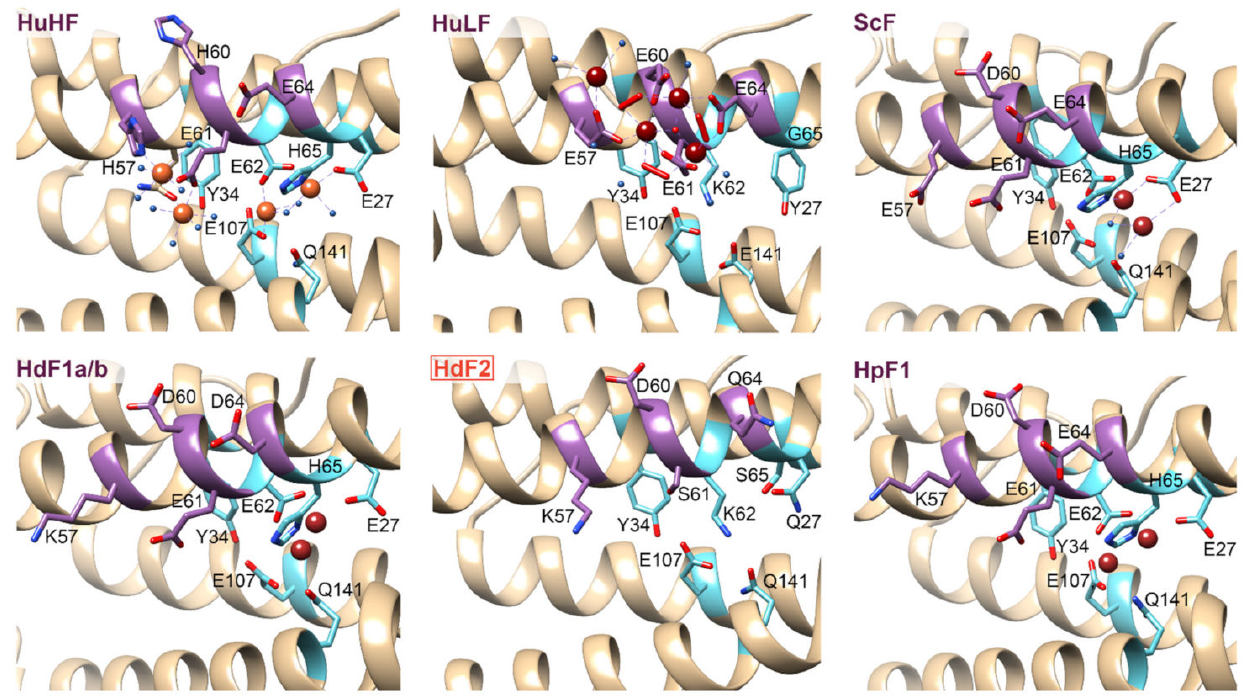
Figure 3. 3D structures of the regions corresponding to ferroxidase di-iron center (cyan) and nucleation site (purple) of H. sapiens ferritins HuHF and HuLF (PDB IDs: 4OYN, 5LG8), bivalve Sinonovacula constricta ScF (PDB ID: 6LP5), and sponges H. dujardini and H. panicea ferritins. Sponge ferritins’ structures are modeled with SWISS-MODEL server [41] using ScF as a template. Molecular graphics was prepared using UCSF Chimera software [42]. Orange and brown spheres represent Fe 3+ and Fe 2+ ions, respectively. Amino acids numbers correspond to conventional human HuHF numbering starting after the initial